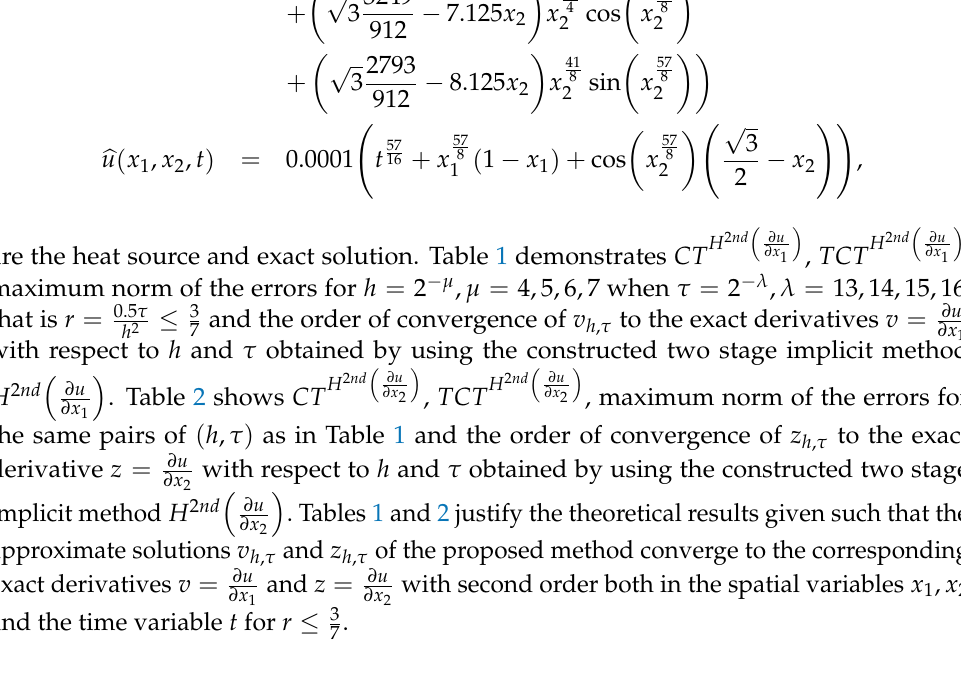
Table 1. Computational time, maximum norm of the errors, and the order of convergence of v h , τ to the exact derivative v = ∂ u r = 0.5 τ h 2